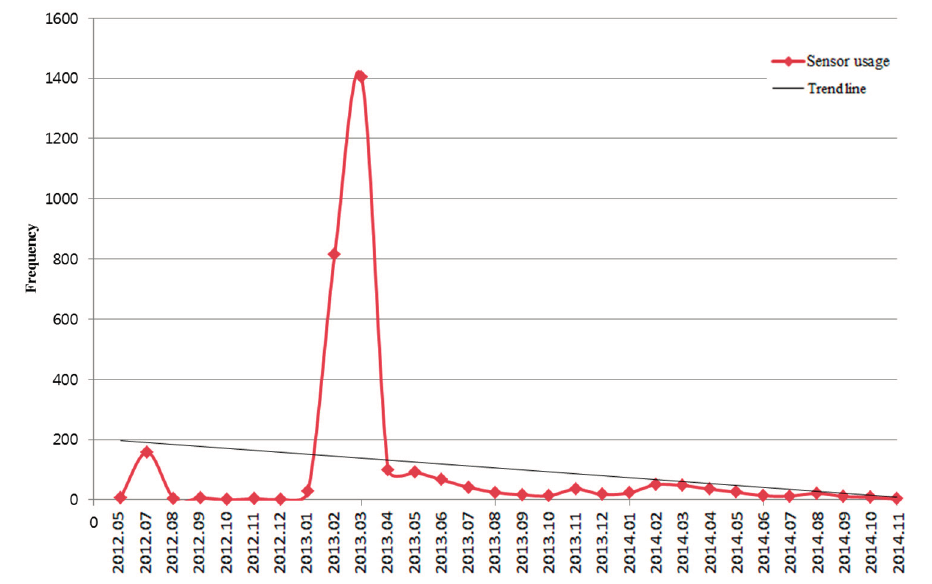
Figure 8. Frequency of usage of the “Blood Culture” app by